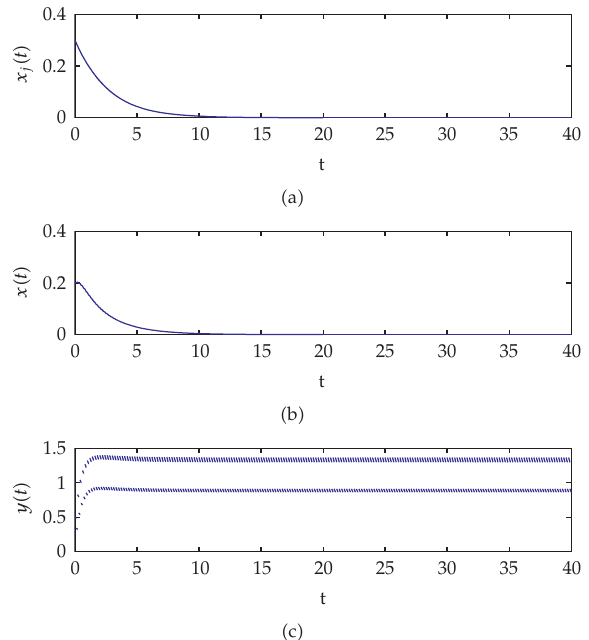
Figure 2: Time series of system (cid:3) 2.4 (cid:4) with parameters d (cid:8) 0 . 6; d 1 (cid:8) 0 . 4; α (cid:8) 0 . 8; τ (cid:8) 0 . 8; d 2 (cid:8) 0 . 5; β (cid:8) 0 . 8; λ (cid:8) 0 . 9; p (cid:8) 0 . 3; μ (cid:8) 0 . 5; T (cid:8) 0 .